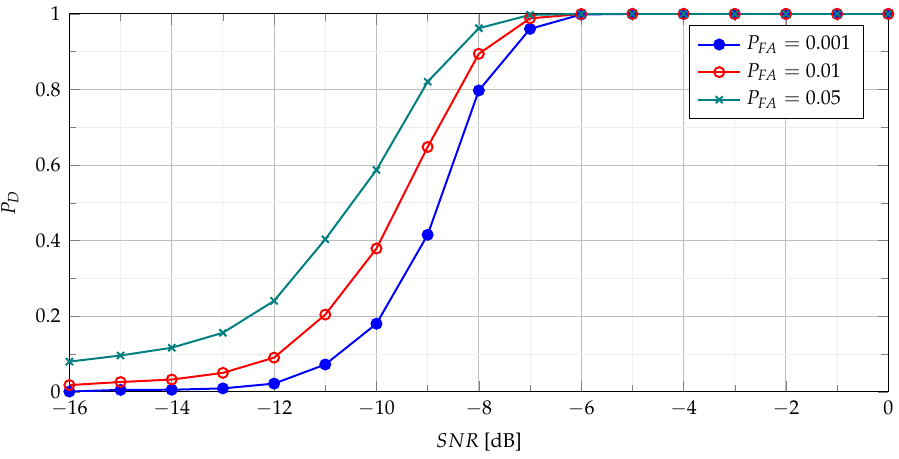
Figure 4. Probability of detection with use of the TCPF statistics for different P FA in various SNR con- ditions.